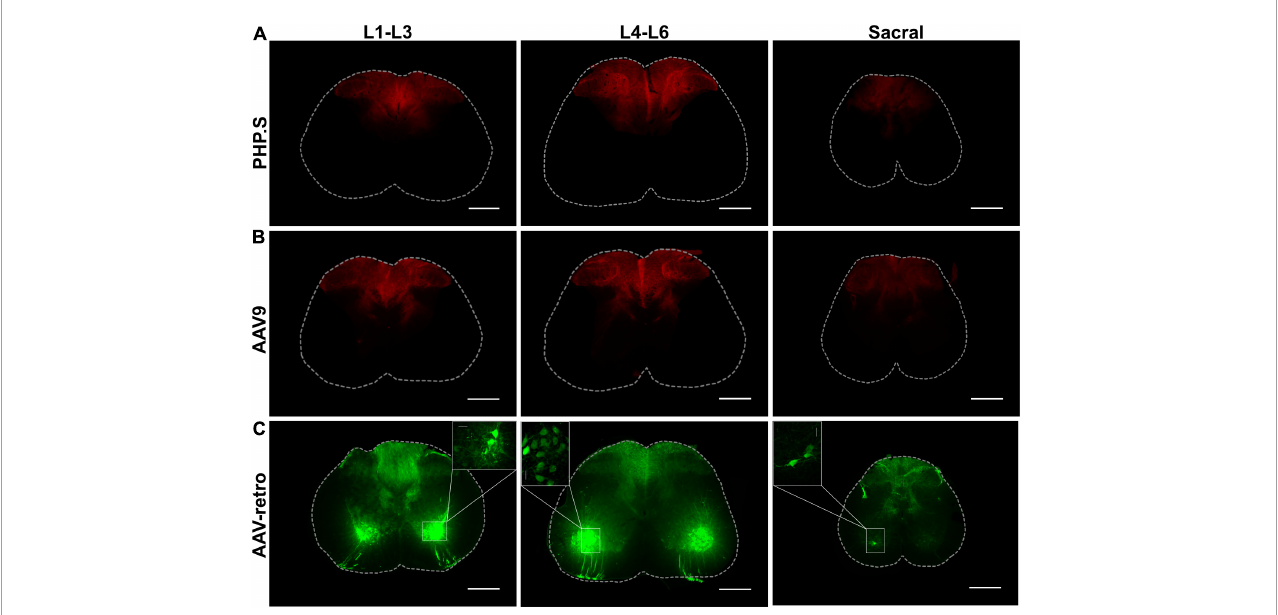
FIGURE3 PHP.S, AAV9, and adeno-associated viruses (AAV)-retro transduce sensory neurons innervating the dorsal horn of the spinal cord, while only AAV-retro transduced neurons in the ventral horn. (A) Representative images of tdTomato expression from three different spinal cord segments in PHP.S injected animals (scale bar, 500 µ m). (B) Representative images of tdTomato expression from three different spinal cord segments in AAV9 injected animals (scale bar, 500 µ m). (C) Representative images of GFP expression from three different spinal cord segments in AAV-retro injected animals (scale bar, 500 µ m). The insets magnify cell body transduction in the ventral horn at a lower exposure (scale bar, 50 µ m).